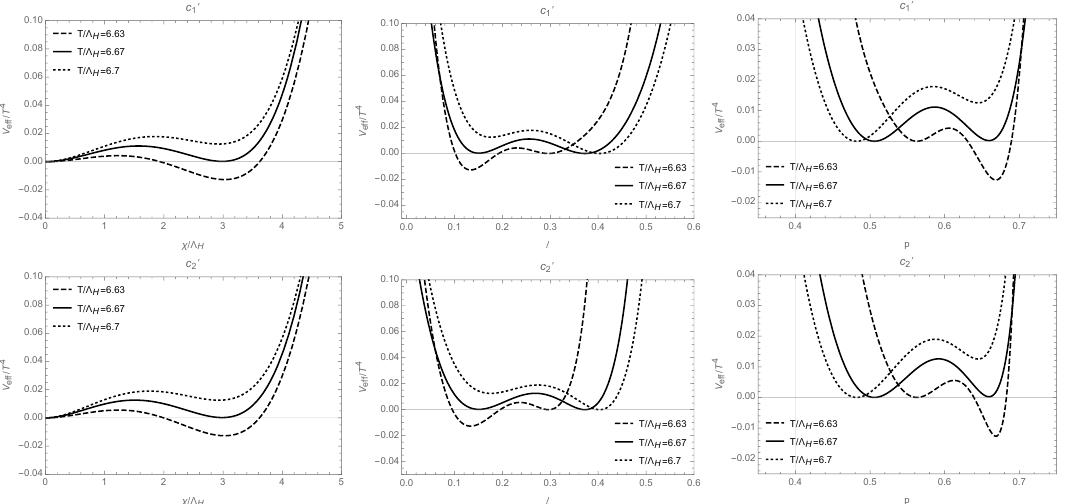
(red) and c 0 (blue) linking the two minimum points given 1 2